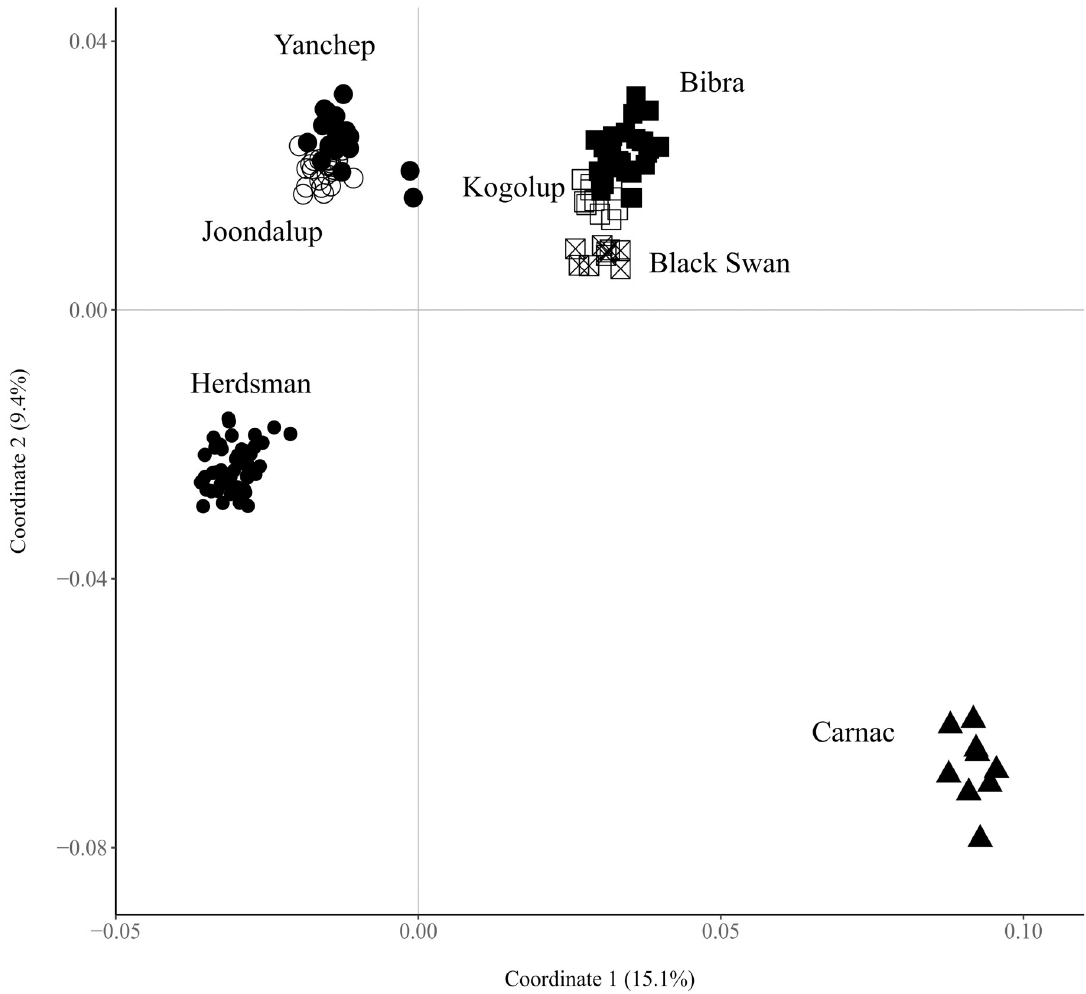
Fig 2. Multidimensional scaling plot of genetic distance between Notechis scutatus occidentalis individuals from Perth, Western Australia. Each population has been given a unique icon. Axis one explained 15.1% and axis one explained 9.4% of the total variance.